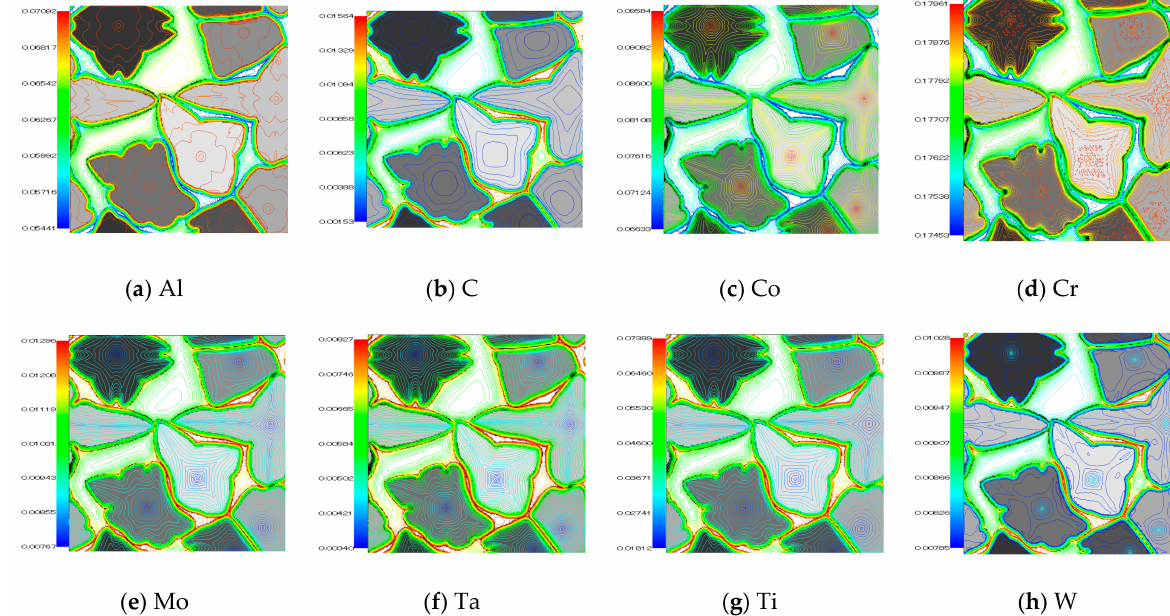
Figure 1. Solute concentration and γ grain distributions obtained by the non-equilibrium multi-phase field method (MPFM) at 0.06 ms at a cooling rate of 10 5 K/s. ( a – h ) are Al, C, Co, Cr, Mo, Ta, Ti and W molar fractions,